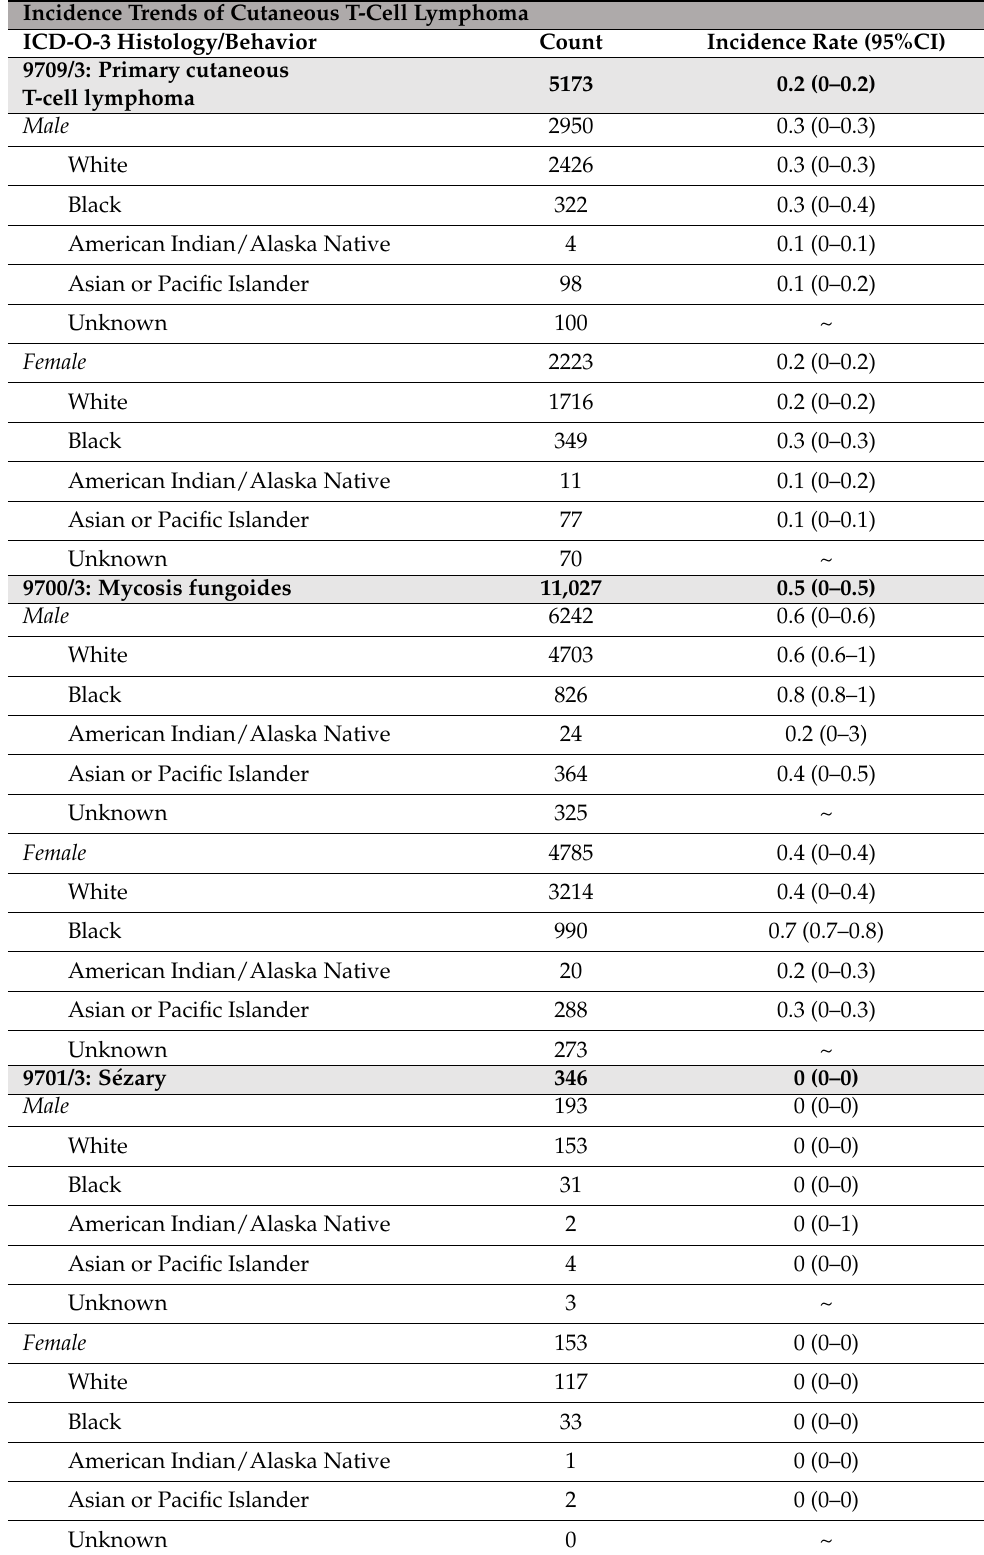
Table 4. National incidence rates by sex and race. Incidence Trends of Cutaneous T-Cell Lymphoma ICD-O-3